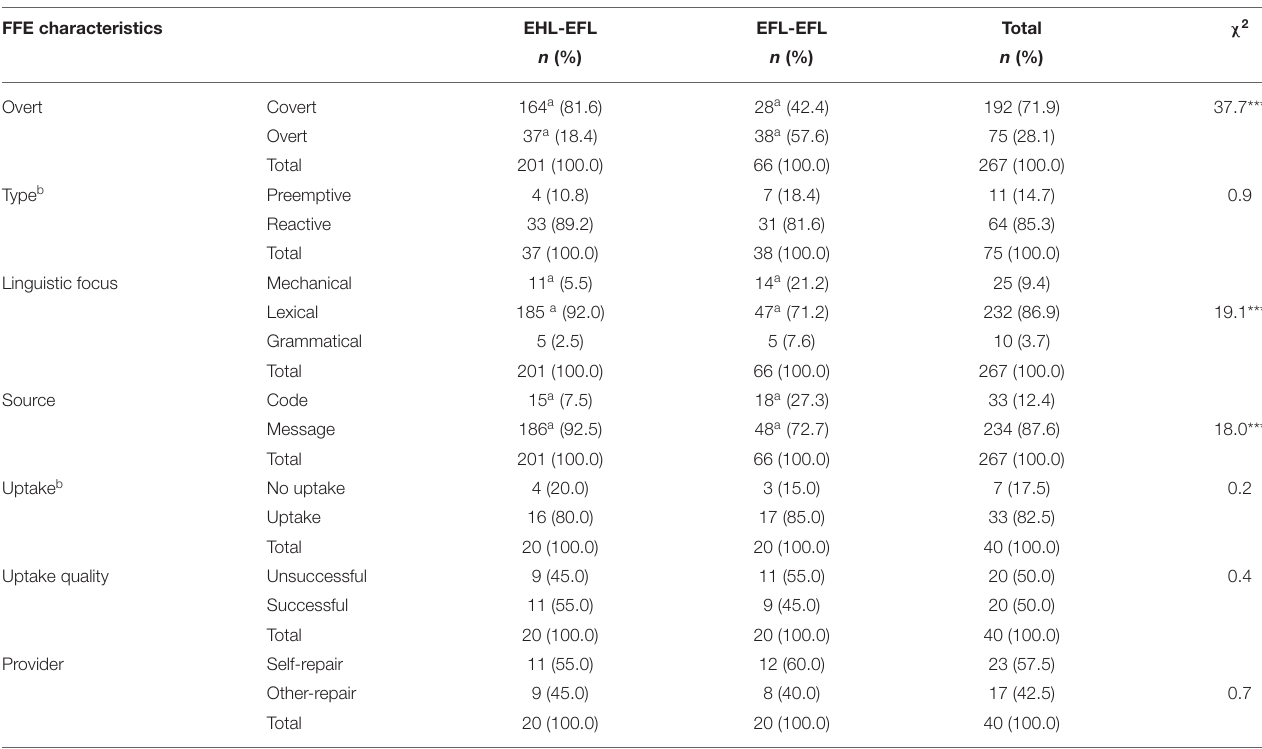
TABLE 4 | Characteristics of FFEs of EHL-EFL and EFL-EFL groups. FFE